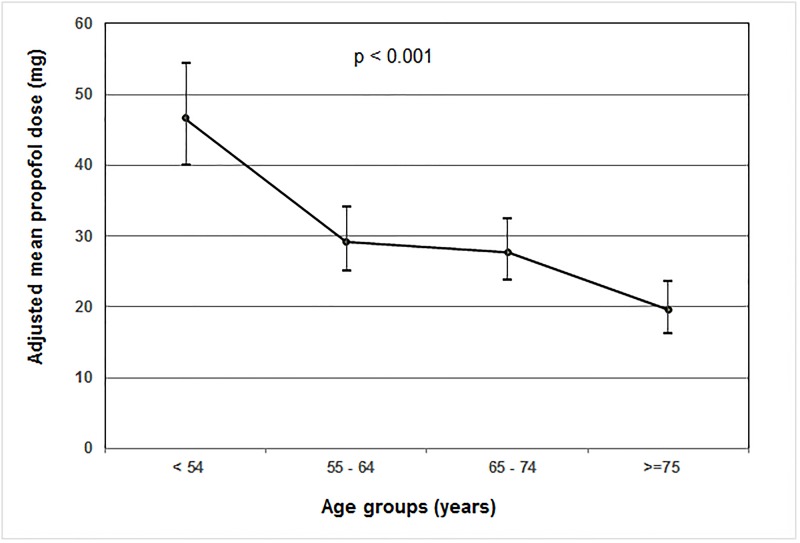
Adjusted mean total dose of propofol according to age groups.